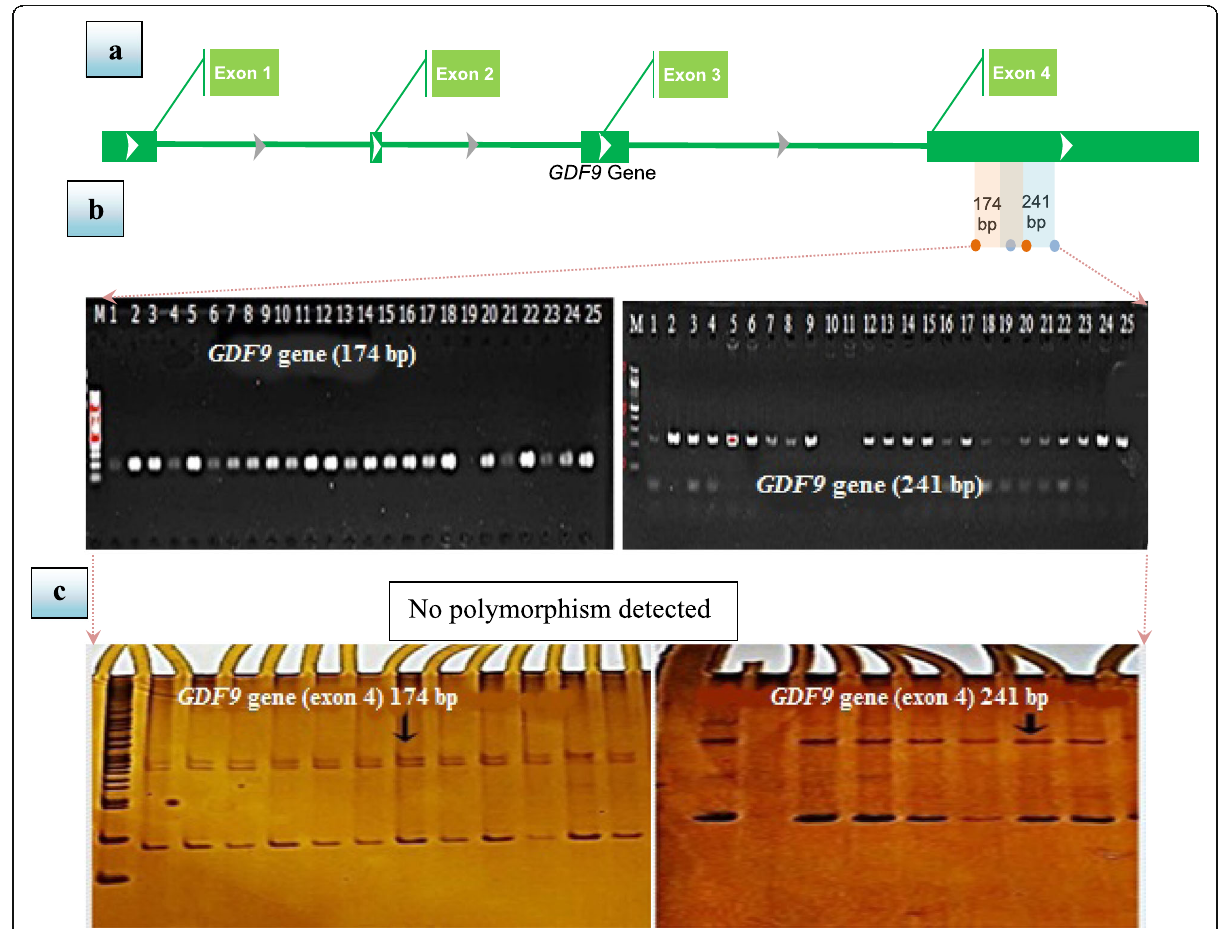
Fig. 1 A schematic diagram of the current study to assess the GDF9 gene polymorphism. a The exact genomic position of the human GDF9 gene was described according to GenBank acc. no. NG_047051.1. b Agarose gel electrophoresis (2%) of polymerase chain reaction (PCR) product of GDF9 gene. c SSCP analysis of PCR products of GDF9 gene. No polymorphisms were identified in the GDF9 gene (exon 4) for two